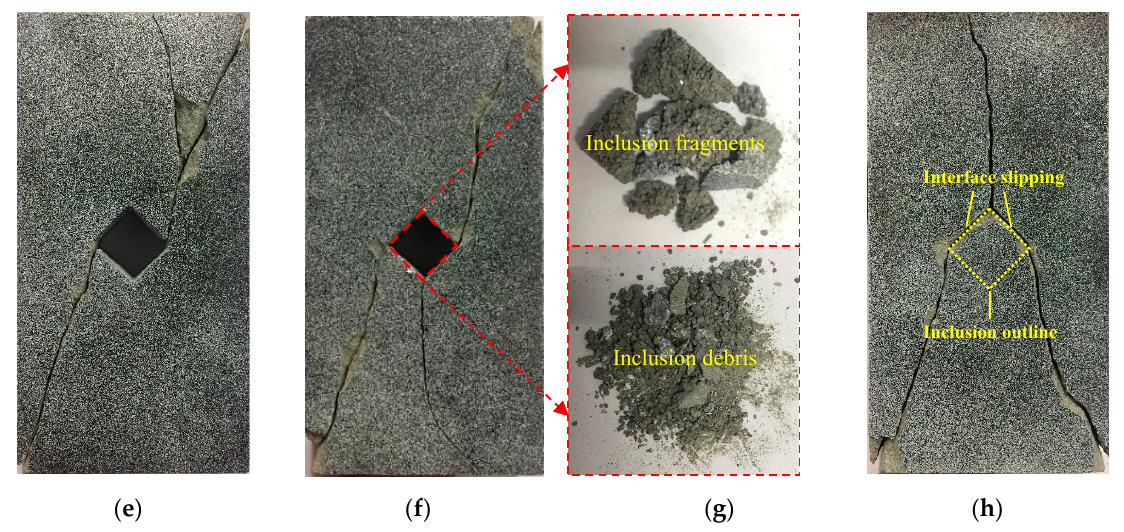
Figure 12. Failure patterns of sandstone specimens under different filling modes and hole angles: ( a ) Sq-0-A; ( b ) local enlarged drawing of the square hole in Figure 12a; ( c ) Sq-0-B; ( d ) Sq-0-C; ( e ) Sq-45-A; ( f ) Sq-45-B; ( g ) inclusion fragments and debris from the hole in Figure 12e; ( h ) Sq-45-C.